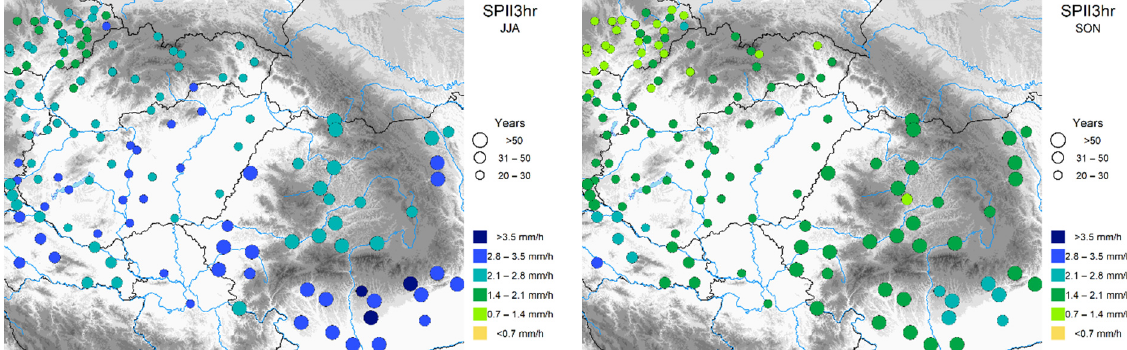
Figure 7. Seasonal averages of the 3-h precipitation intensity (SPII3hr). The circles and their sizes are the same as in Figure 3.